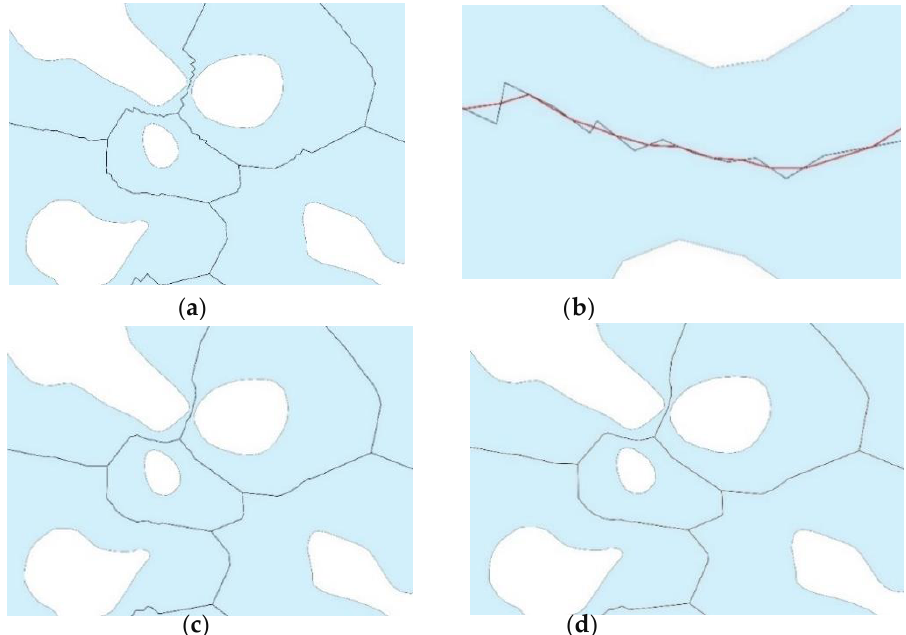
Figure 28. Elimination of zigzag effects in the network skeleton by establishing fixed points at network nodes: ( a ) zigzag effects in the network; ( b ) visualization of the smoothing method; ( c ) results of smoothing after the first iteration; ( d ) results of smoothing after the second iteration.